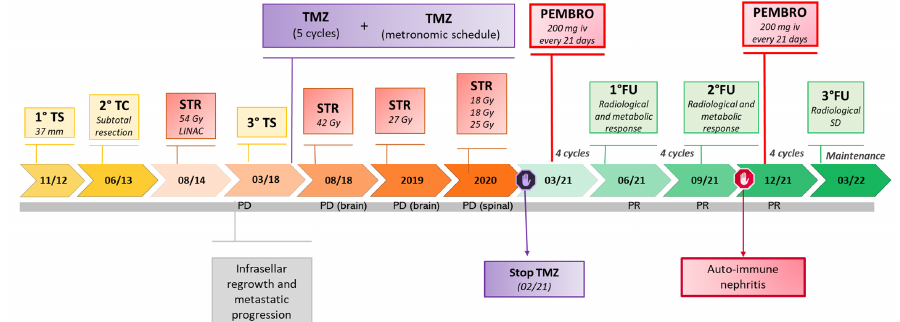
Figure 1. Timeline of disease progression and treatment in a silent Pit1 aggressive PitNET with a secondary metastatic dissemination: Metastatic dissemination was observed together with local progression after 2 neurosurgical operations—transsphenoidal (TS) and transcranial (TC), and an initial response to post-operative stereotactic radiotherapy (STR). After re-operation on the primary site (TS), temozolomide (TMZ) was first given as a classical fractionated schedule—340 mg/d, 5 days every 28 days—for 5 cycles, followed by a metronomic schedule (120 mg then 80 mg/d) for 30 months. Complementary STR was also given to the primary site and to multiple metastatic sites (brain and spinal). Pembrolizumab (Pembro) was started 200 mg/21 days in March 2021 and, after a short transient withdrawal because of auto-immune side effects including nephritis after cycle 8, is still ongoing at the time of the current report, with mild persisting cutaneous effects managed by discontinuous low-dose steroid therapy.